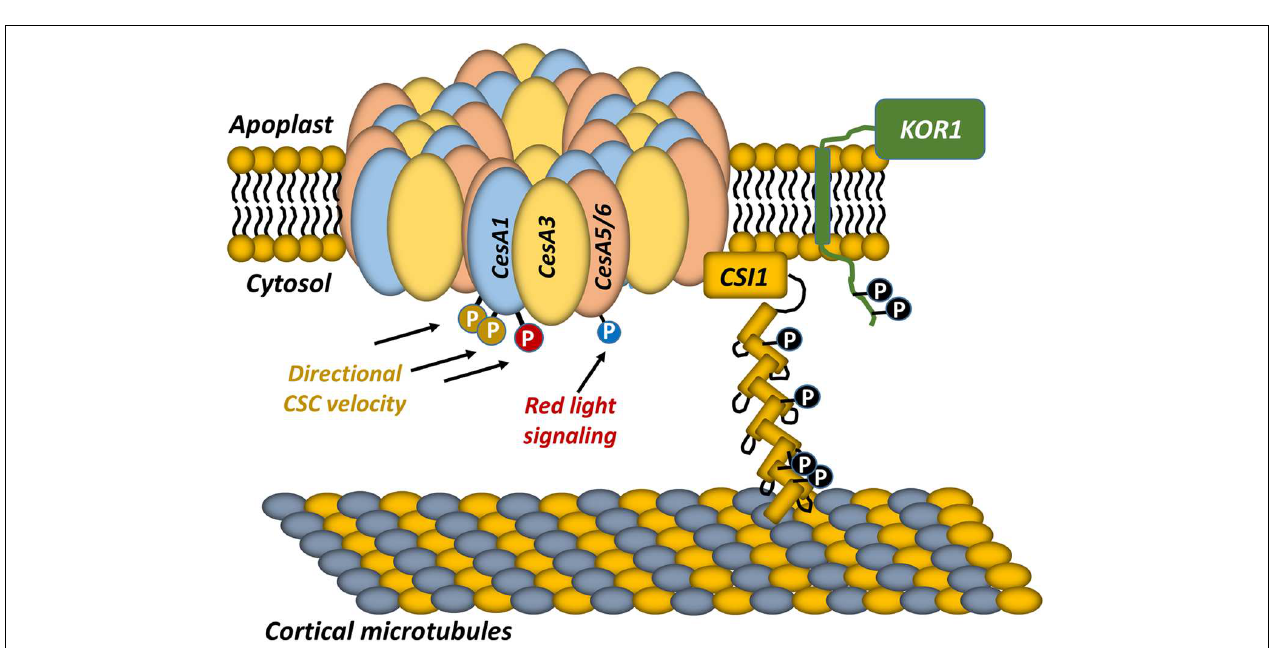
FIGURE 3 | Current model of CSC regulation by post-translational phosphorylation. The composition of the primary cell wall CSC is shown. The CSC contains three non-redundant CESA subunits that are likely organized into a hexamer of hexamers, resulting in 36 CESA subunits within the CSC. The CSC is guided along trajectories that are defined by cortical microtubules underlying the plasma membrane, and the association of the CSC with cortical microtubules is mediated by Cellulose Synthase Interactive protein 1 (CSI1). KORRIGAN1 (KOR1) is also a component of the CSC. Each of these proteins is phosphorylated at multiple positions. Previous studies indicated that CESA5 phosphorylation (blue phosphate) is involved in regulating the velocity of the CSC during red-light stimulation (Bischoff et al., 2011). Other studies have linked CESA1 phosphorylation sites to differential CSC velocity that is microtubule-dependent (Chen et al., 2010). However, numerous phosphorylation sites within the CSC, and its accessory subunits remain to be